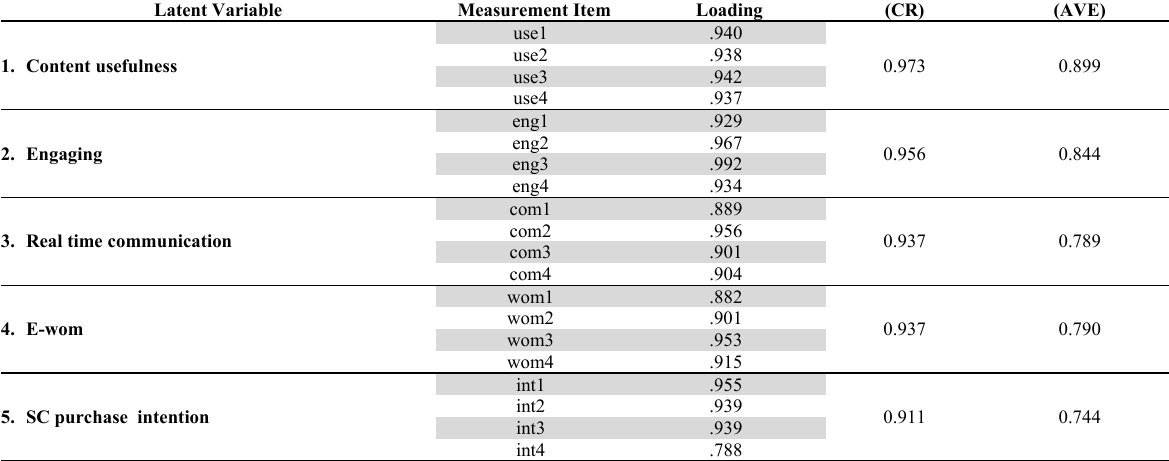
Convergent validity